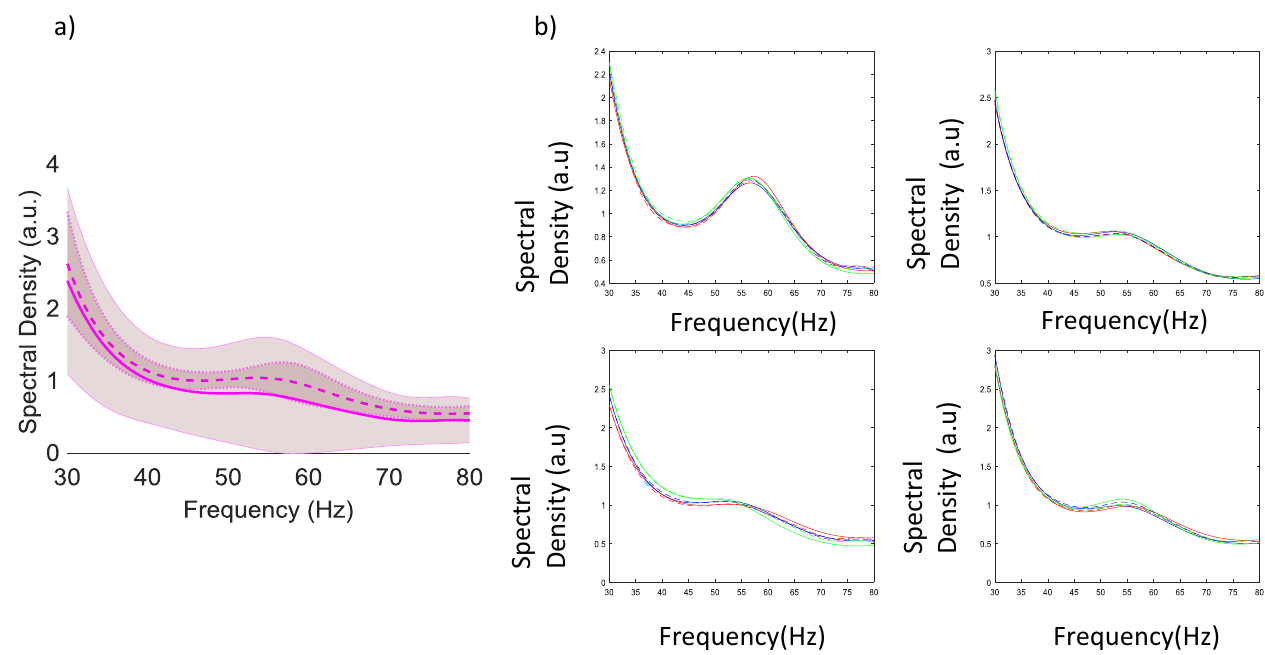
Fig. 3 Model fi ts to data. a Empirical responses (power spectra) and model fi ts are shown in dashed and solid lines along with 95% con fi dence intervals across subjects for the data from ref. 20 (smallest stimulus size; grand average across all subjects). These quantify variability across subjects and overlap for model predictions and data predictions. Differences in power spectra between conditions for the same subject are small and spectra corresponding to different stimulus sizes overlap. b Example model fi ts to individual subjects in data from ref. 16 . Fits are obtained for all three stimulus sizes simultaneously by modeling different sizes as condition-speci fi c effects. The three stimulus sizes correspond to red, blue and green lines. Dashed and solid lines correspond to data and